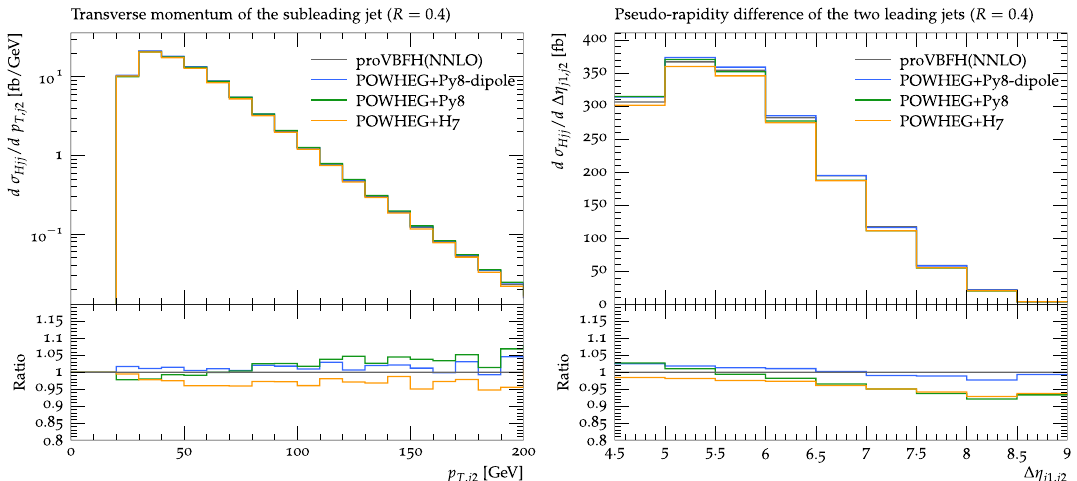
POWHEG-BOX matched with HERWIG7 and PYTHIA8 using two dif- ferent recoil schemes. No hadronisation effects are taken into account